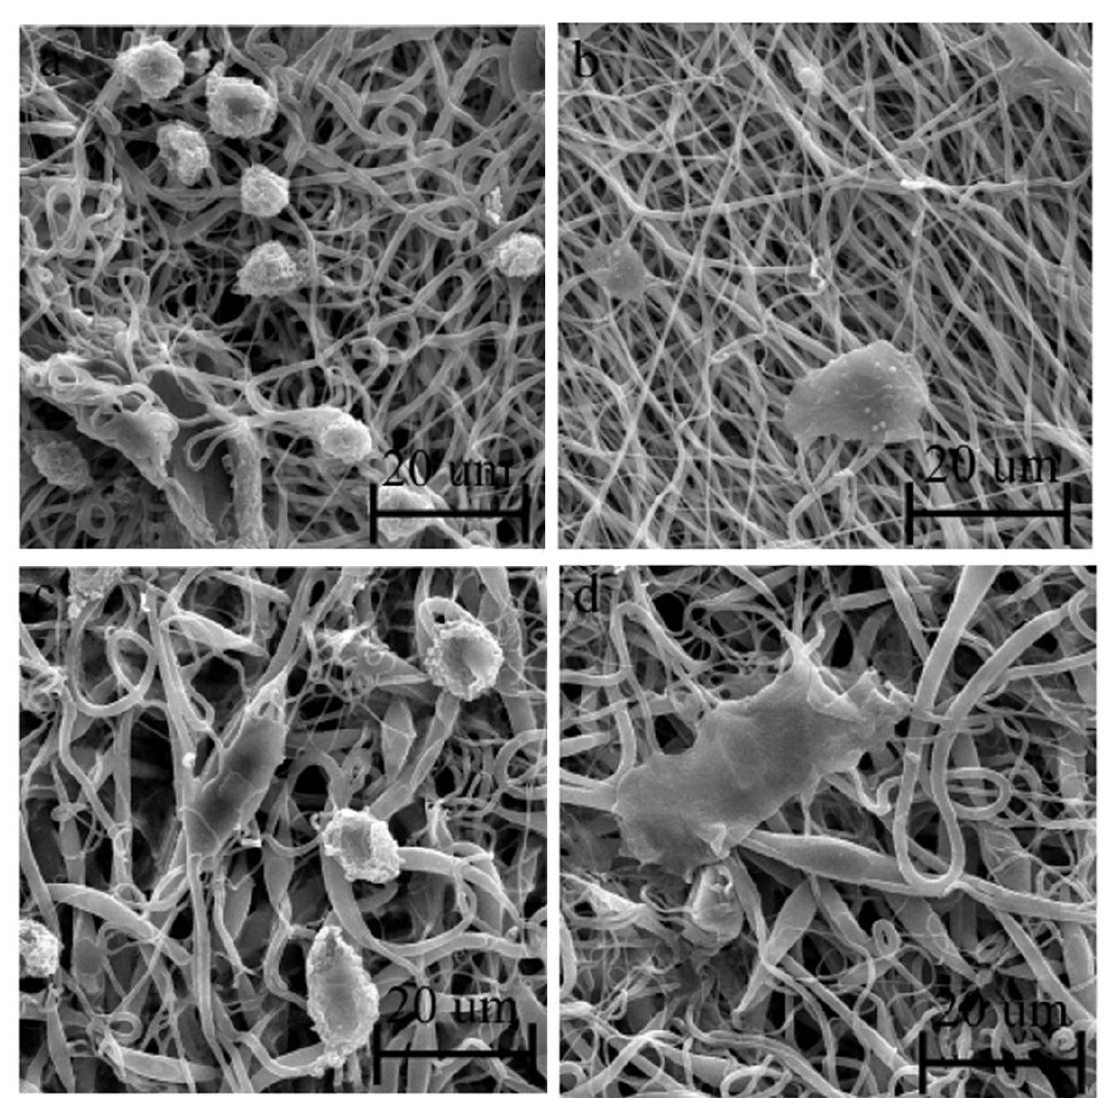
Figure 14. Cell attachment evaluations by SEM analysis, PCL fibers after one day ( a ) and three days ( b ) of cells seeding, 5MNP fibers after one day ( c ) and three days ( d ) of cells seeding.